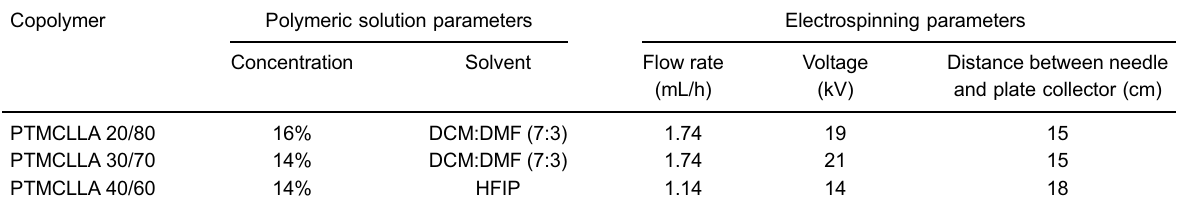
Table 1. Parameters tested for scaffold